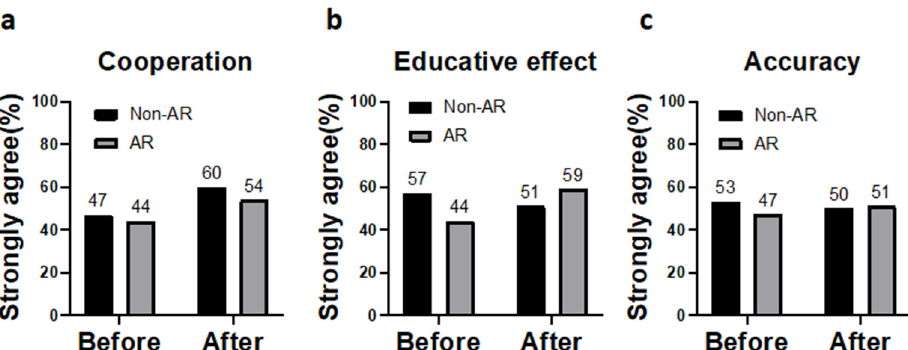
Figure 4. Perceived feasibility of the perioperative rehabilitation program before and after the designated program: ( a ) familiarity; ( b ) confidence; ( c ) anxiety.